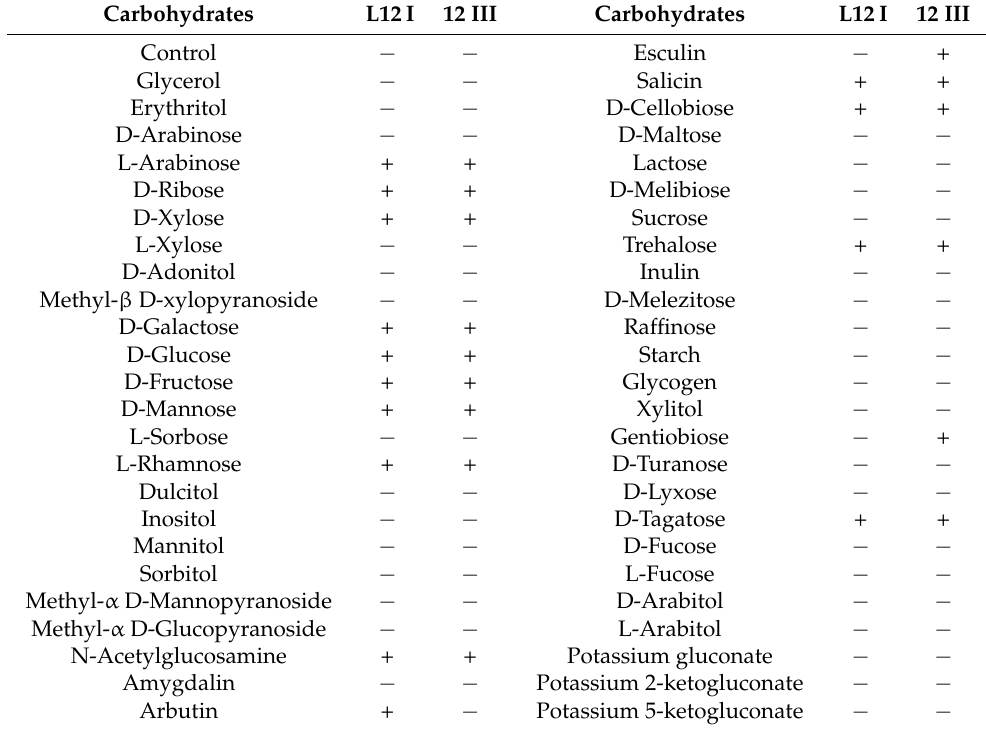
Table 2. Characteristics of carbohydrate fermentation patterns of selected bacteria.